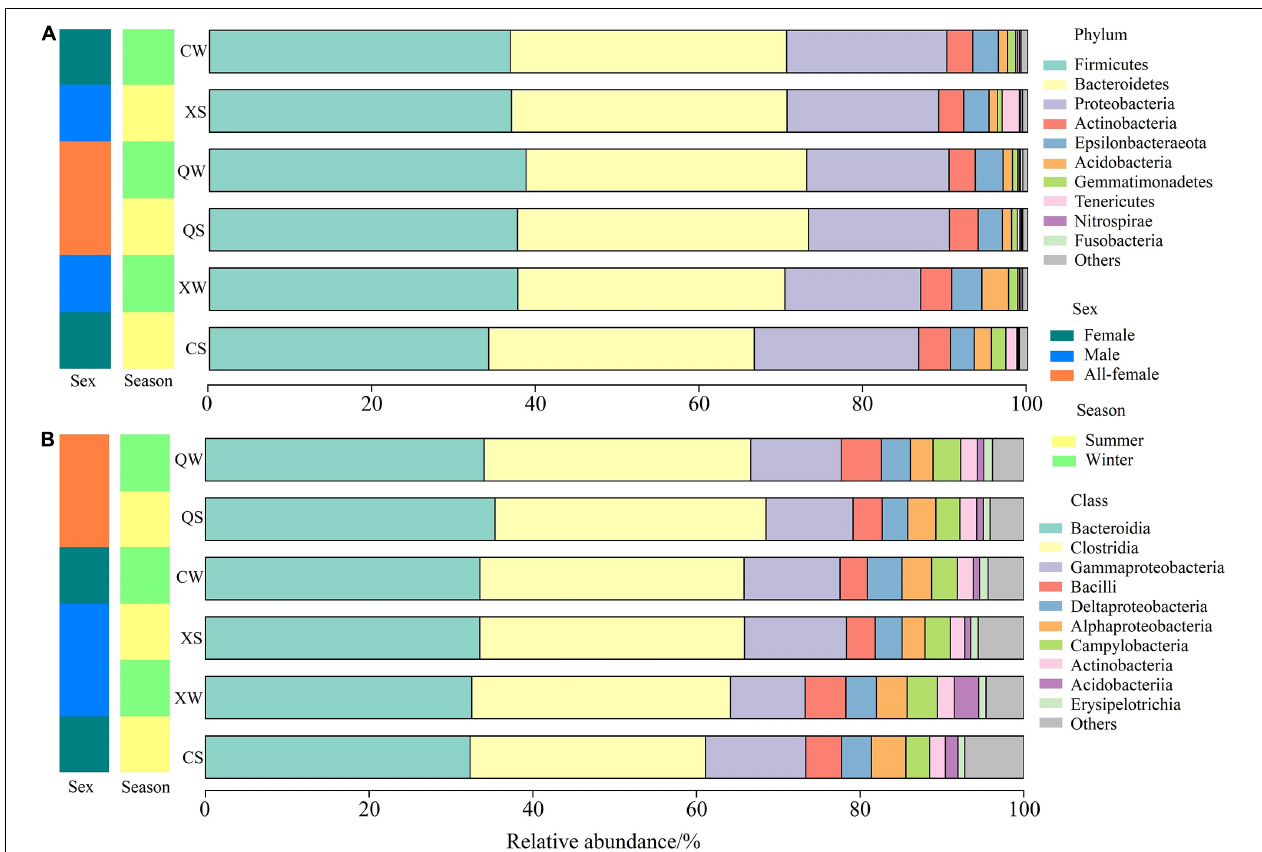
FIGURE 4 | Relative abundances of different phyla (A) and classes (B) in the intestine of Nibea albiflora male, female, and all-female fish during an investigation of the composition of their intestinal microbiota.